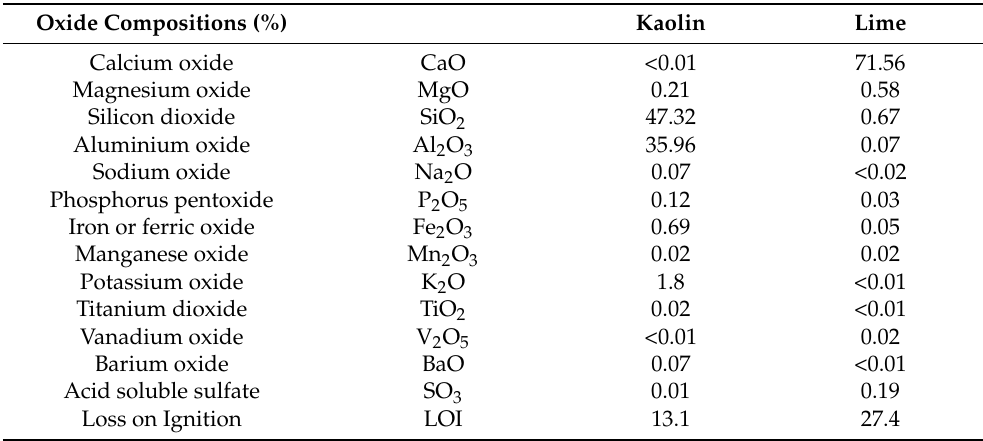
Figure 1. X-ray diffractogram of kaolin soil, obtained using x-ray diffraction analysis through commercial service at the University of Bath. (Note: K, kaolinite and Q, quartz). Table 1. Oxide compositions of kaolin and lime, obtained using x-ray fluorescence analysis (XRF) through commercial service by Celtest Company Limited.